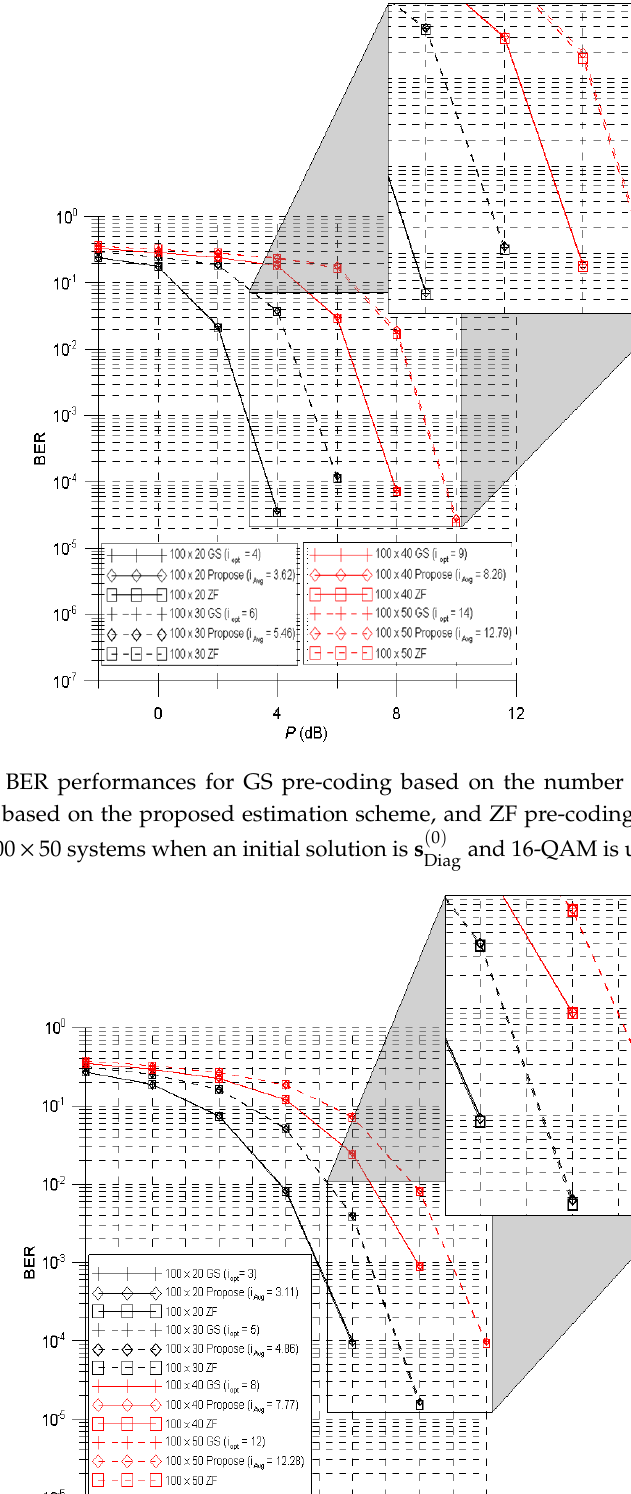
Figure 9. The BER performances for GS pre-coding based on the number of optimal iterations, GS pre-coding based on the proposed estimation scheme, and ZF pre-coding in 100 × 20, 100 × 30, ( 0 ) 100 × 40, and 100 × 50 systems when an initial solution is s and 64-QAM is NS,Stair